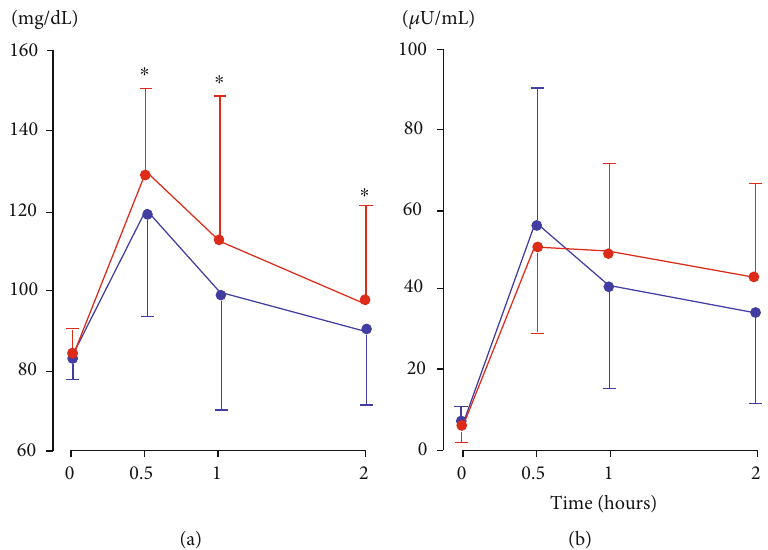
Figure 1: Responses of plasma glucose (a) and serum insulin (b) during a standard 75 g oral glucose tolerance test in young Japanese women with positive (red lines) and negative (blue lines) family history of type 2 diabetes. Mean ± SEM . ∗ p < 0 : 05